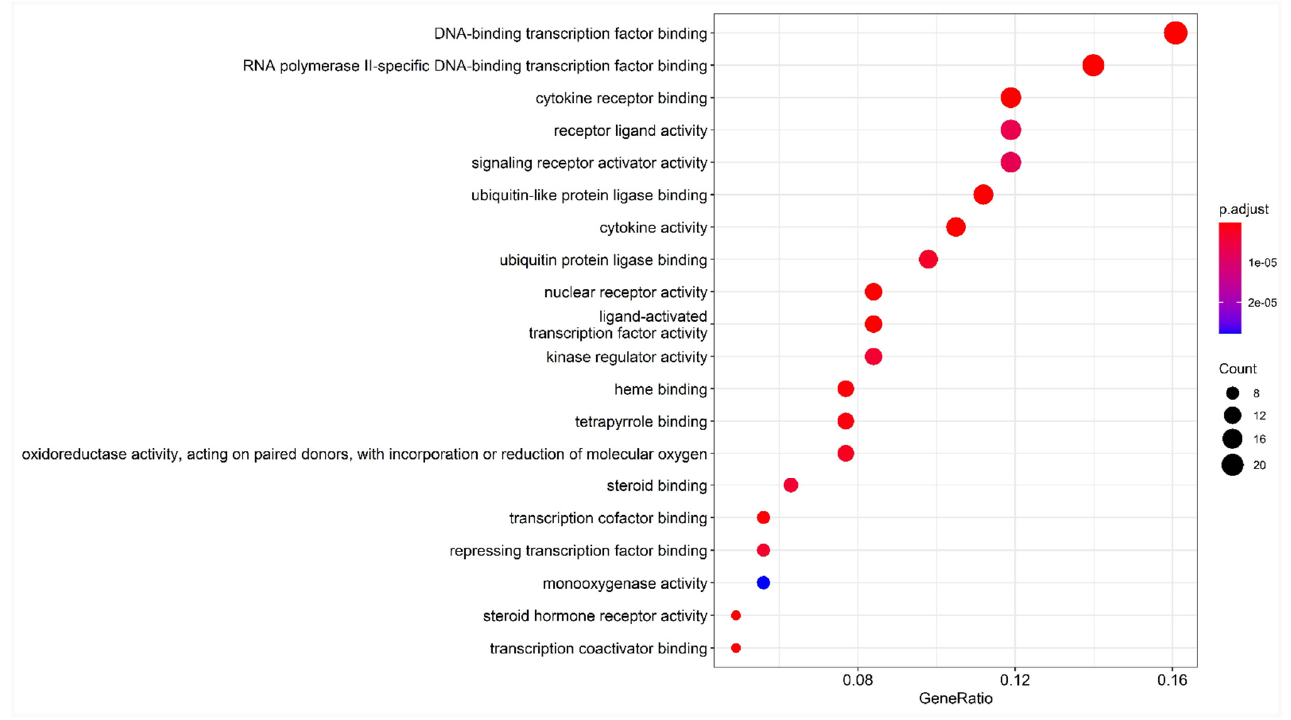
Figure 5. Bubble chart of GO enrichment analysis. Note: the abscissa is the gene ratio, the ordinate is the enriched pathway, the size of the point represents the number of genes, and the color represents the level of p -value.